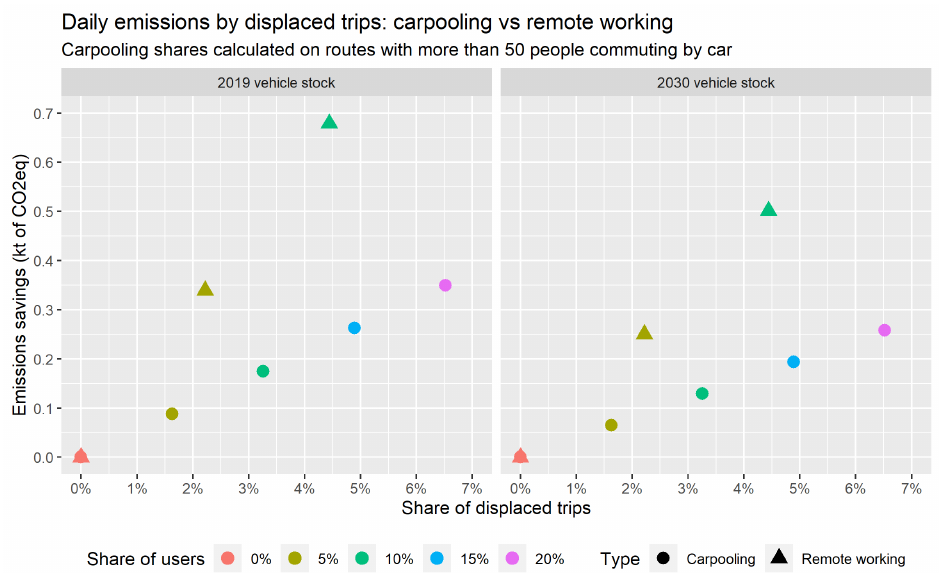
Figure 8. The effect of carpooling on daily GHG emissions of commuting trips in Lombardy, com- pared with remote working. Carpooling is limited to routes with more than 50 people commuting by